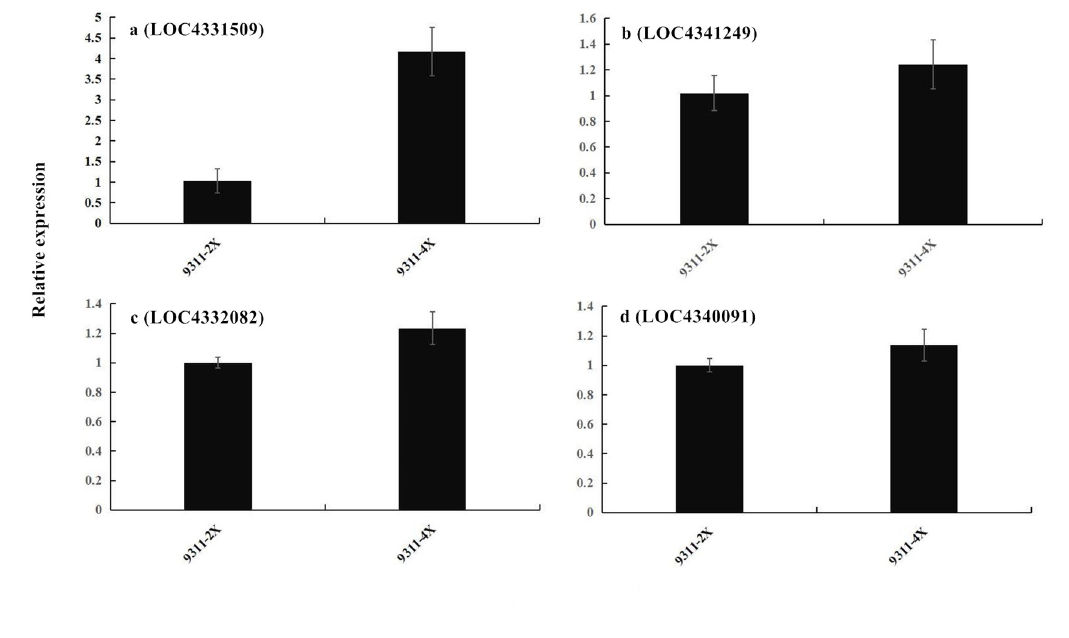
Fig 6. Changes in the transcription of genes related to antioxidant enzymes. (a) Os03g0131200 for CAT, (b) Os06g0547400 for POD, (c) Os03g0343500 and (d) Os06g0143000 for SOD, in rice seed 9311-4x and 9311-2x. Values are presented as means ± SE. Significance levels for comparing 9311-4x vs. 9311-2x: Fig 6A: P < 0.01; Fig 6B–6D: P <